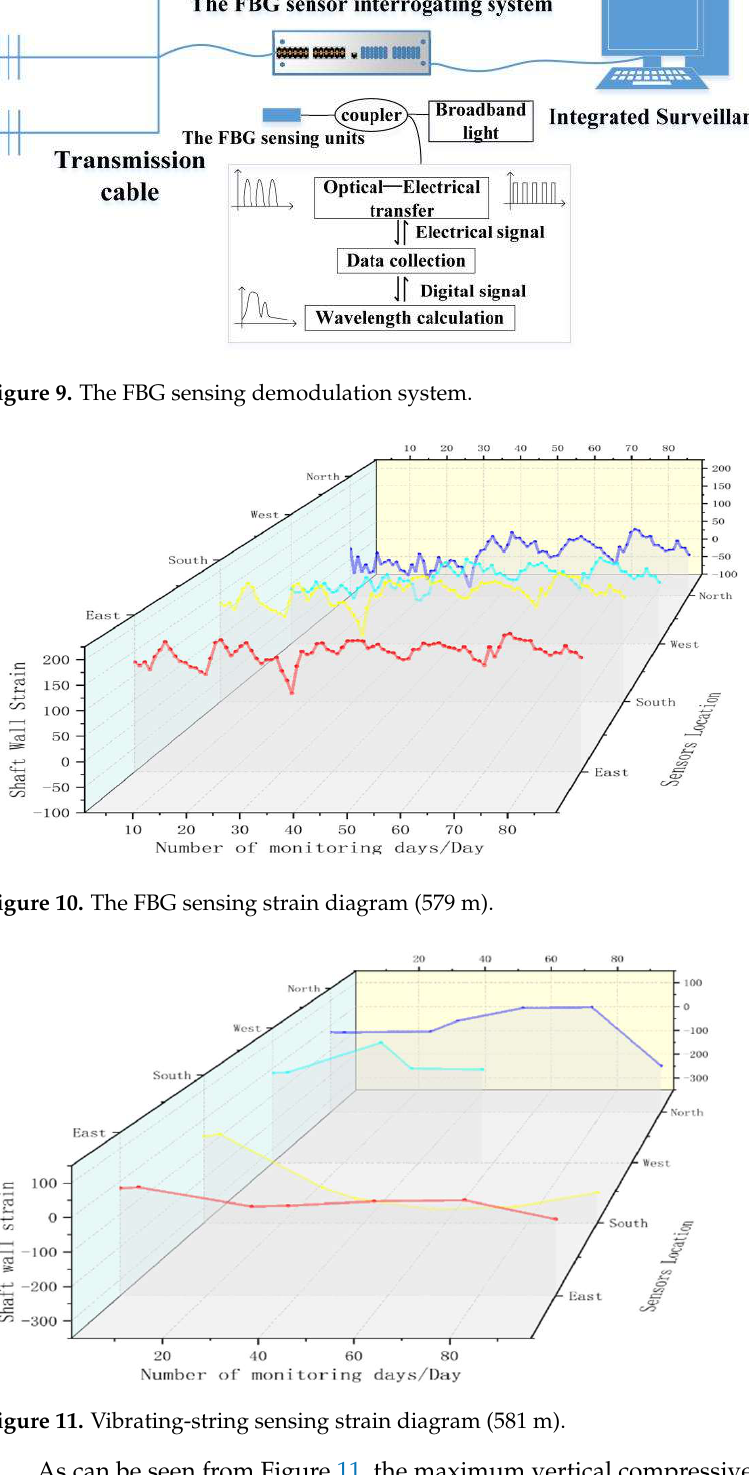
Figure 11. Vibrating-string sensing strain diagram (581 m).